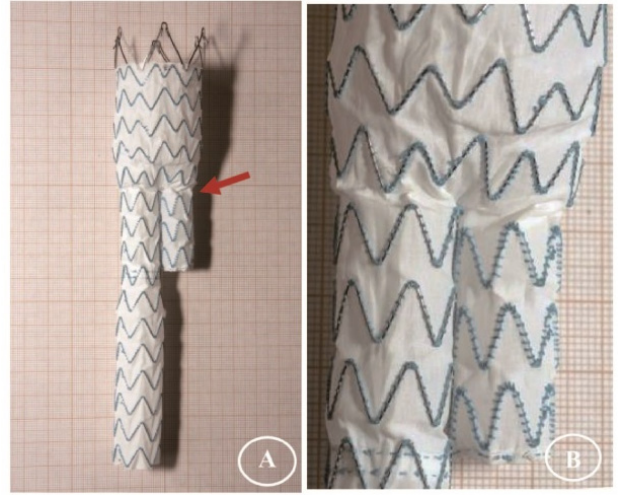
Figure 13. Endurant stent ‐ graft. The fabric of the body and the limbs are supported by M ‐ stents ( A ). Twisting might still exist in the vicinity of the crotch at the bifurcation ( A : arrow), which is shown magnified ( B ).